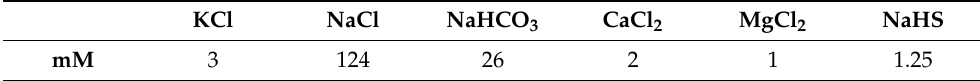
Table 2. Chemical composition of the artificial cerebrospinal